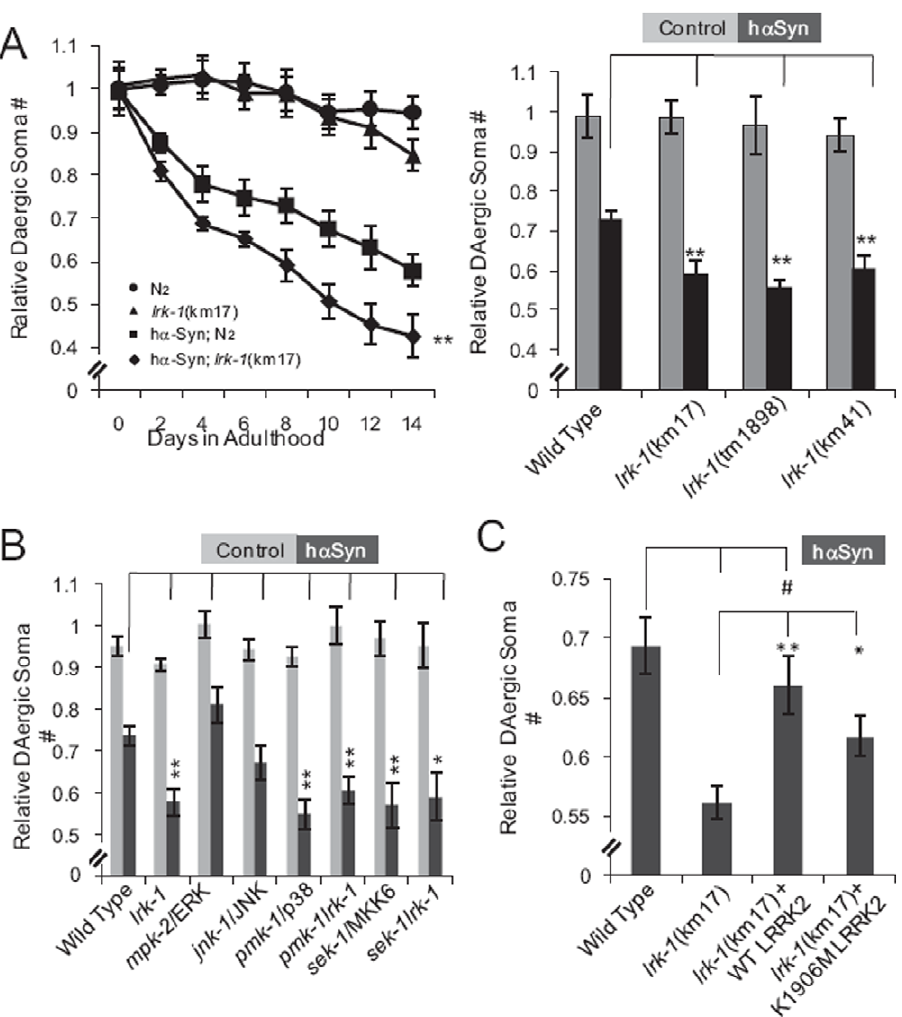
Figure 3. LRRK2 signaling protects against h a Syn-mediated DAergic soma degeneration in C.elegans . Quantification of DAergic neurons in nematodes of different genotypes with or without expression of human a -synuclein (h a Syn) in DAergic neurons. The number of DAergic somas was normalized to the mean number of DAergic somas observed in wild type (N2) L4 nematodes throughout this study, as described in Experimental Procedures. ( A ) Human a -synuclein induced death of DAergic neurons in nematodes is enhanced by mutations in components of the LRRK2 and p38 signaling pathway. Left panel, quantification of DAergic neuron degeneration as a function of age in Bristol N2 (N2, circles), loss-of-function mutant lrk-1 (km17) (triangles), human a -synuclein (h a Syn)-expressing (in DAergic neurons) N2 (h a Syn; N2, squares), and h a Syn-expressing lrk-1 ( km17 ) (h a Syn; lrk-1 (km17), diamonds) nematodes. The data shown represent the mean 6 SEM of four independent experiments. Each experiment employed 20–30 nematodes. **, p , 0.01 by two-way ANOVA. Right panel, quantification of DAergic neurons in wild type (Wild type) and different alleles of loss-of-function mutant lrk-1 ( km17 , tm1898 and km41 ) day 8 nematodes without (control, grey) or with (h a Syn, black) DAergic-specific expression of h a Syn. Data represent the mean 6 SEM of four independent experiments. Each experiment employed 20–30 nematodes. **, p , 0.01 by one-way ANOVA with Dunnett’s test. For control (Wild type) and lrk-1 ( km17 ) nematodes with and without h a Syn expression, the data in the right panel corresponds to that shown in the left panel for Day 8 (the same animals produced both data sets). ( B ) lrk-1 functions together with pmk-1 and sek-1 to protect against h a Syn-induced DAergic neurodegeneration. Quantification of DAergic neurons in wild type and the indicated single and double mutant day 8 nematodes without (control, grey) or with (black) DAergic-specific expression of h a Syn. Data represent the mean 6 SEM of four independent experiments. Each experiment employed 20–30 nematodes. *, p , 0.05; **, p , 0.01; one-way ANOVA with Dunnett’s test. ( C ) Human LRRK2 functionally substitutes for LRK-1 to protect nematode DAergic neurons from h a Syn-induced degeneration and LRRK2 kinase activity contributes to this protection. Quantification of DAergic neurons in day 8 nematodes including wild type (Wild type), lrk-1 mutant ( km17 ), and km17 with pan-neuronal expression of WT ( lrk-1 + WT LRRK2) or K1906M mutant LRRK2 ( lrk-1 + K1906M LRRK2). All nematode strains also expressed h a Syn in their DAergic neurons. Data represent the mean 6 SEM of four independent experiments. Each experiment employed 20–30 nematodes. # , p . 0.05; *, p , 0.05; **, p , 0.01 by one-way ANOVA with Dunnett’s test.